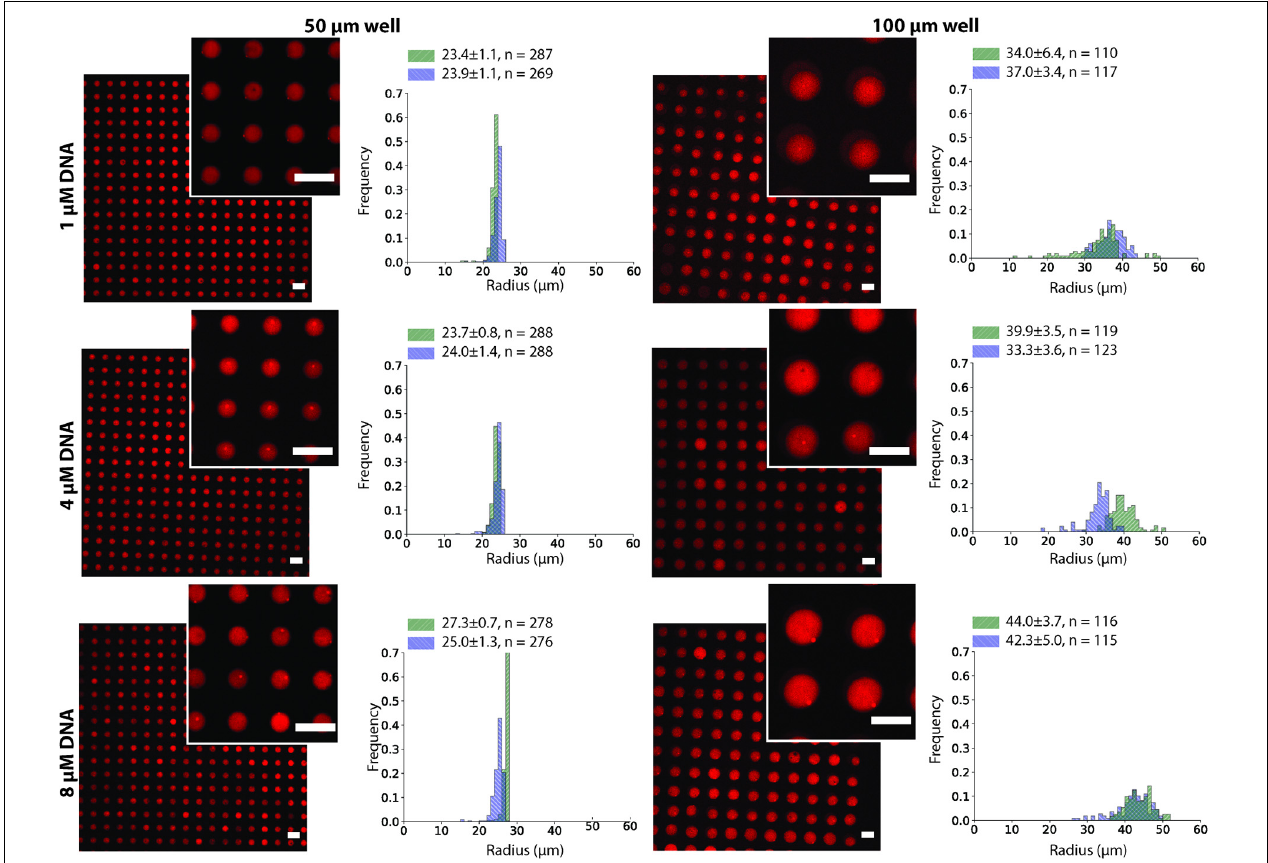
FIGURE 3 | Dex/PEG microdroplet array stained by rhodamine-dextran in 50- and 100- µ m microwells, displaying the droplet size distribution at different DNA concentrations for two separate experiments after two annealing rounds. Labels indicate the average, standard deviation, and size of each sample. Scale bars = 100 µ